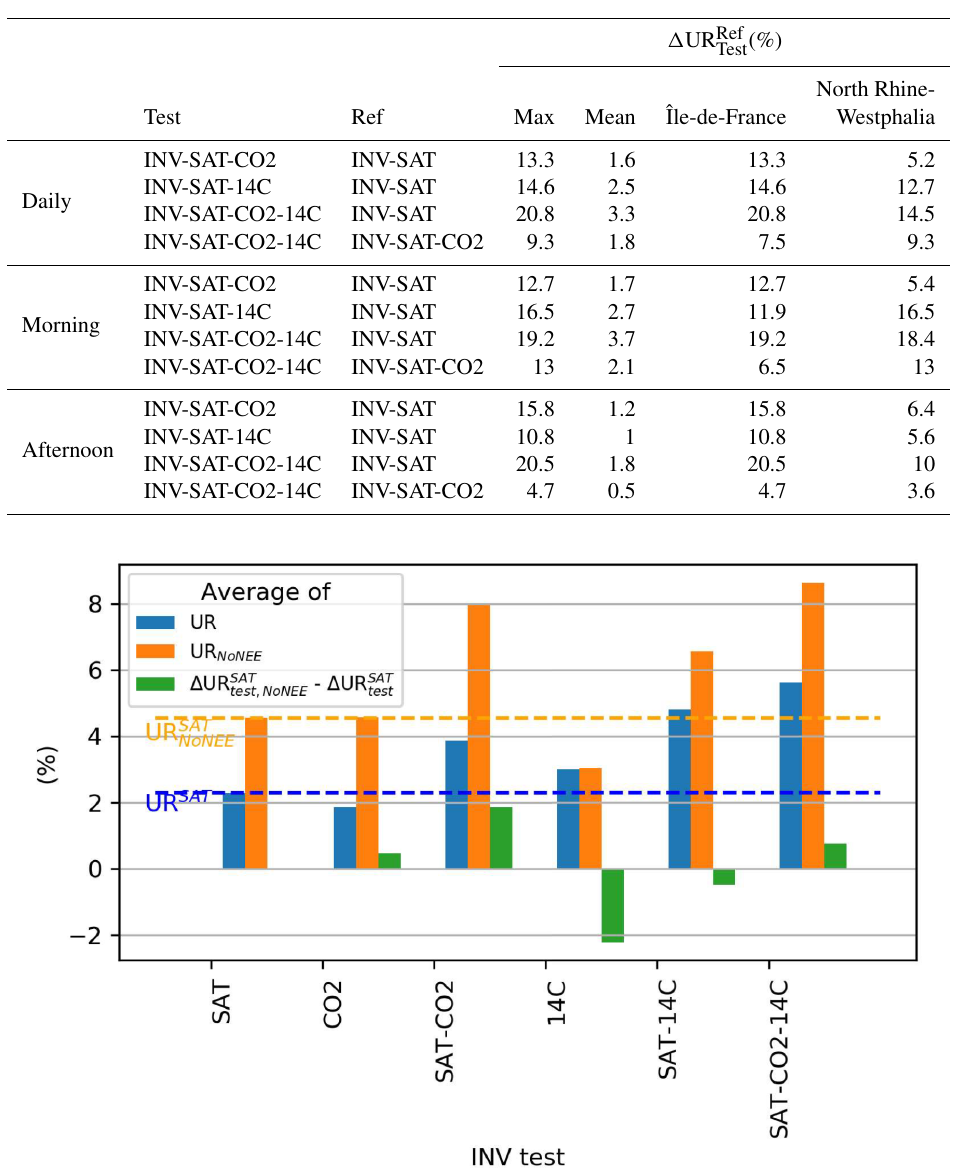
Figure 12. Average on the main area of interest of the UR on 24h FF regional budgets in a set of inversion configurations, with (blue) and without (orange) NEE and average of the difference between (cid:49) UR SAT test with and without NEE (green). Negative values highlight an increase in the additional observation network potential when NEE is taken into account. Positive values highlight a decrease in the additional observation network potential when NEE is taken into account. High absolute values highlight strong NEE impact.